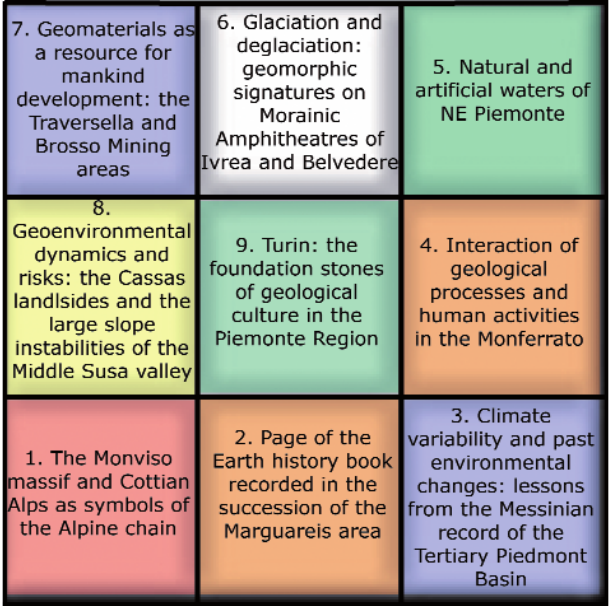
Figure 2. The ‘disassembled Rubik cube’ analogy for the description of the geothematic areas of the PROGEO-Piemonte